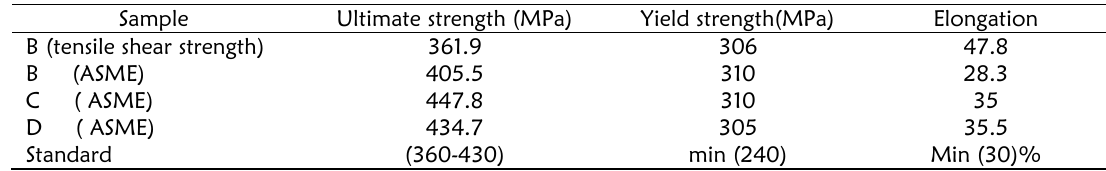
Table 5: The tensile test results of the cylinders on welded